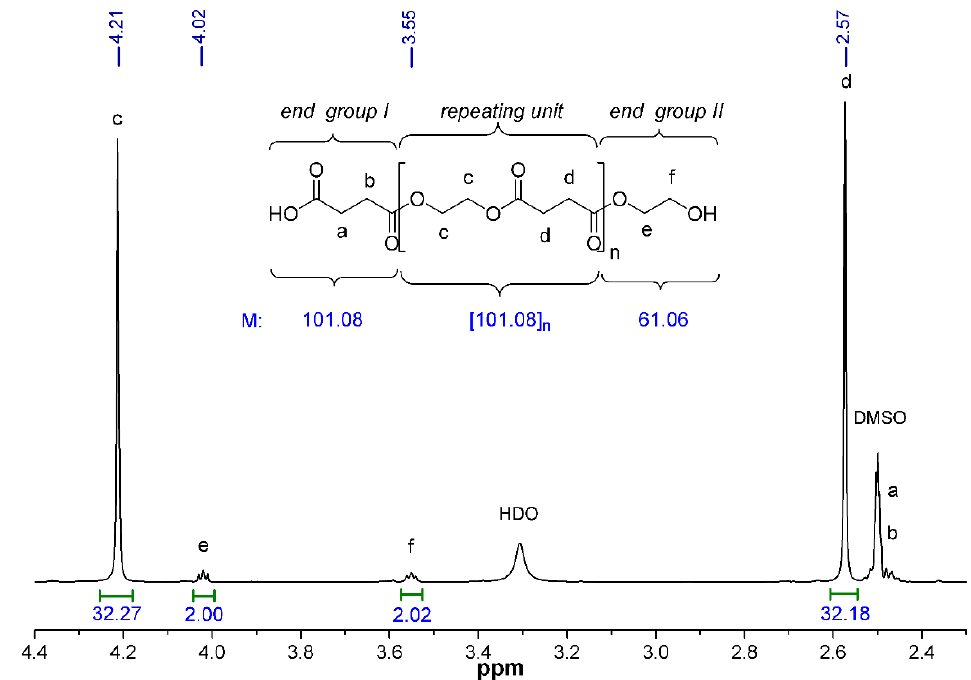
Figure 4. Enlarged partial 1 H NMR spectrum (DMSO- d 6 , 25 °C) of PES-80 min with peak assignments and calculated molecular weights of the structural units.